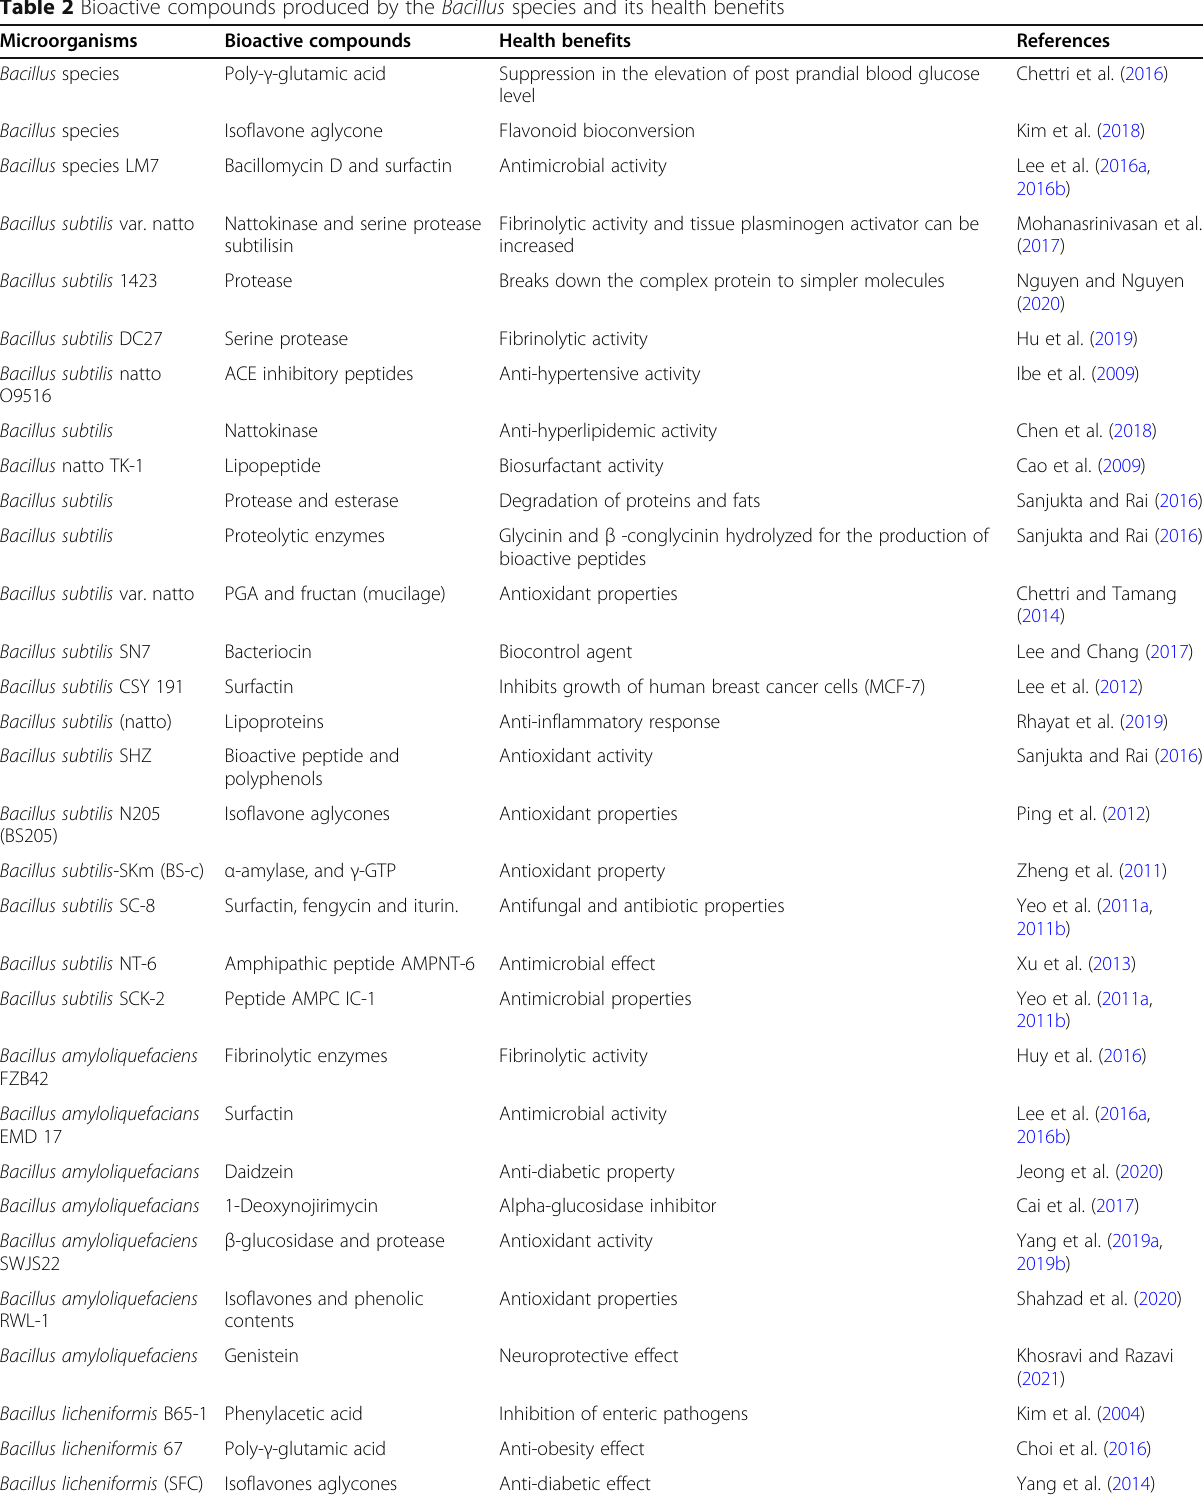
Table 2 Bioactive compounds produced by the Bacillus species and its health benefits